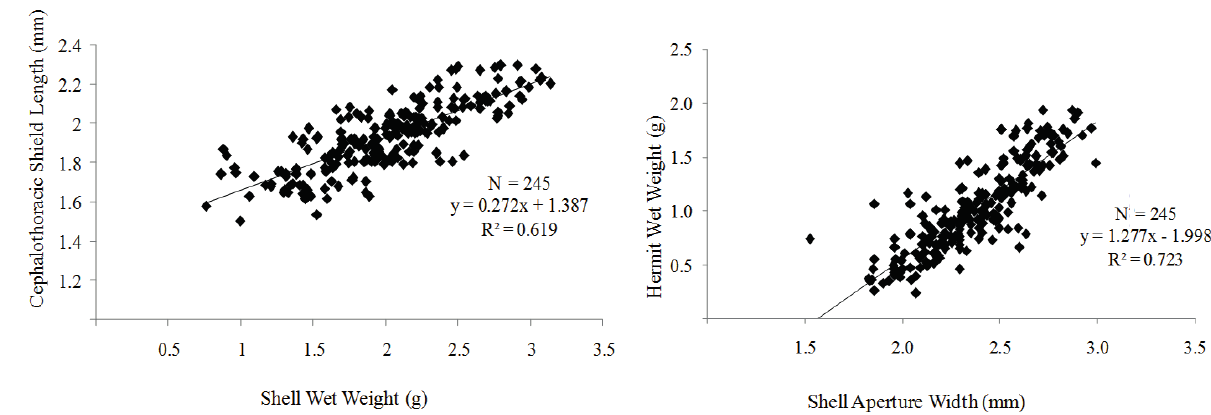
Figure 3. Linear Regression, Cephalothoracic Shield Length (CSL) vs. Shell Wet Weight (SWW) and Hermit Wet Weight (HWW) vs. Shell Aperture Width (SAW) of Isocheles sawayai and the gastropod species Stramonita haemastom a in an area adjacent to Babitonga Bay, Santa Catarina, Brazil.